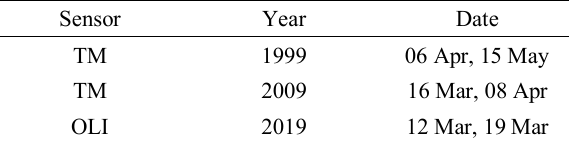
Table 1. Landsat images used in different seasons during the 30- year period (row 157, paths 38 and